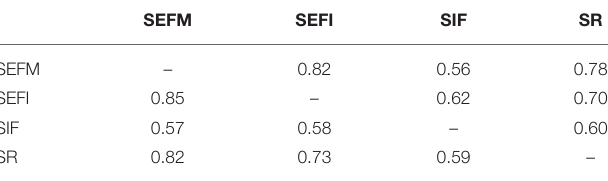
TABLE 4 | Correlations between the four latent